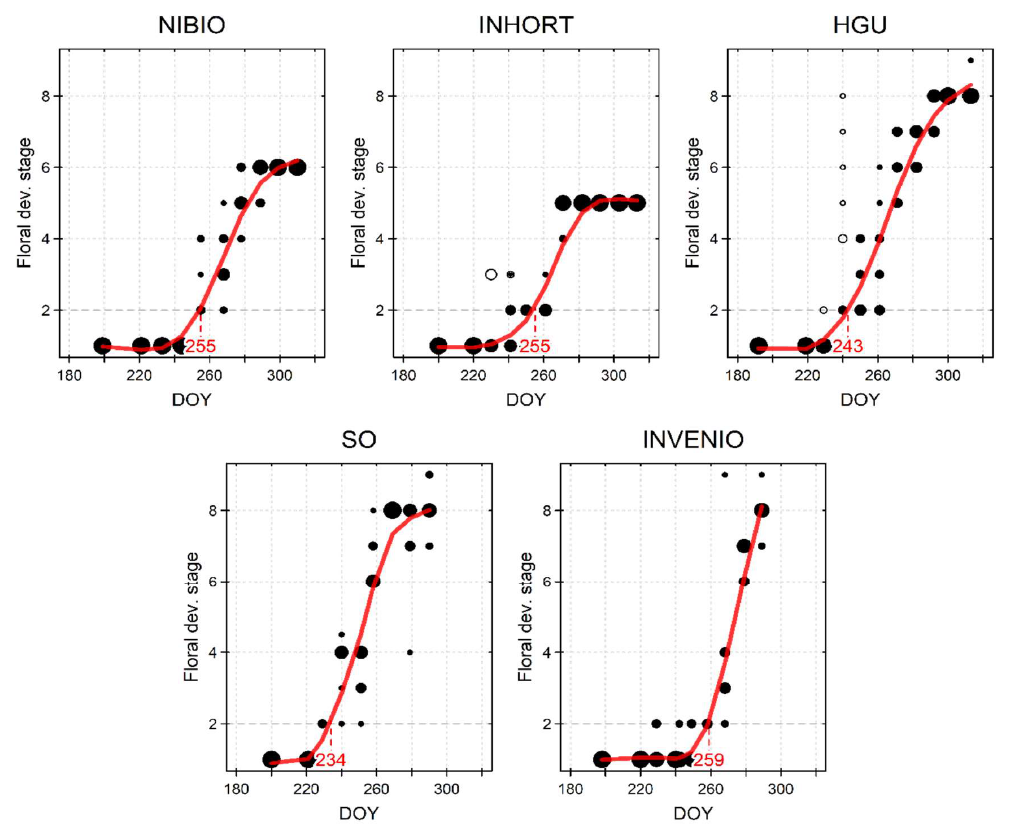
Figure A1. Exemplary calculation of the estimated day of the year (DOY, red number) for flower initiation at floral developmental Stage 2, performed by the cubic spline smoothing function (red line) over the registered floral developmental stages (black dots) at a given DOY for ‘Clery’ grown at five locations in Europe in 2017. The size of the dots represents the frequency of the registered values, and hollow dots represent outlying samples (influencing the shape of the function) that were not included in the calculation.